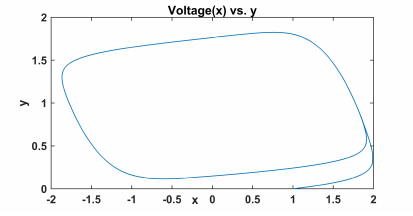
Figure 16. Recovery variable (right) with a constant external current value, I(t) = 3 µ A / cm 2 , a = 0.8 , b = 0.7 & c = 3